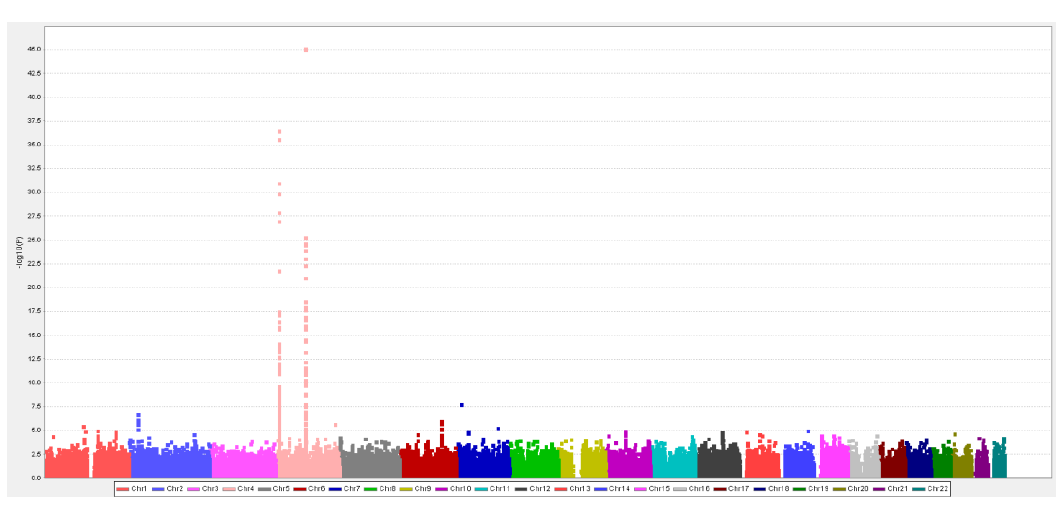
Figure 2. First-stage serum uric acid (SUA)-GWAS results: age, sex, BMI, and five PCs (concerning stratification and batch effects) were adjusted in the linear regression model.